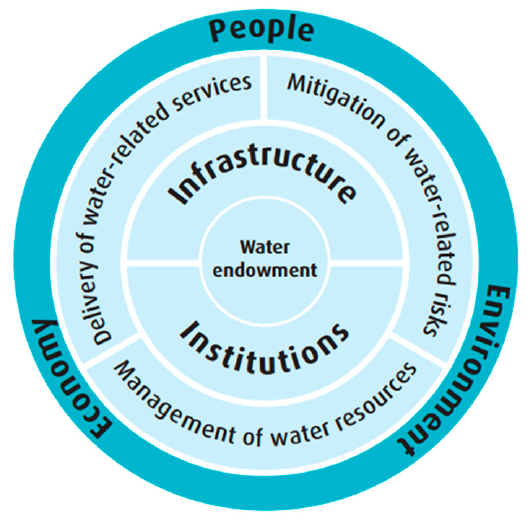
Figure 1. Conceptual framework for water security.